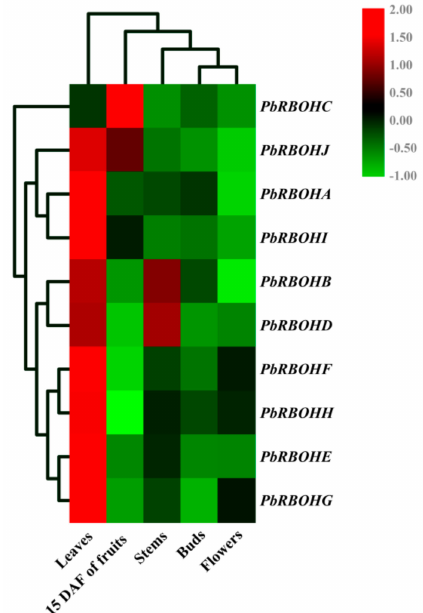
Figure 11. Expression profiles of pear RBOH s across di ff erent tissues. The transcript level of the 10 PbRBOH s in di ff erent tissues (fruits, leaves, stems, buds, and flowers). The expression data of each